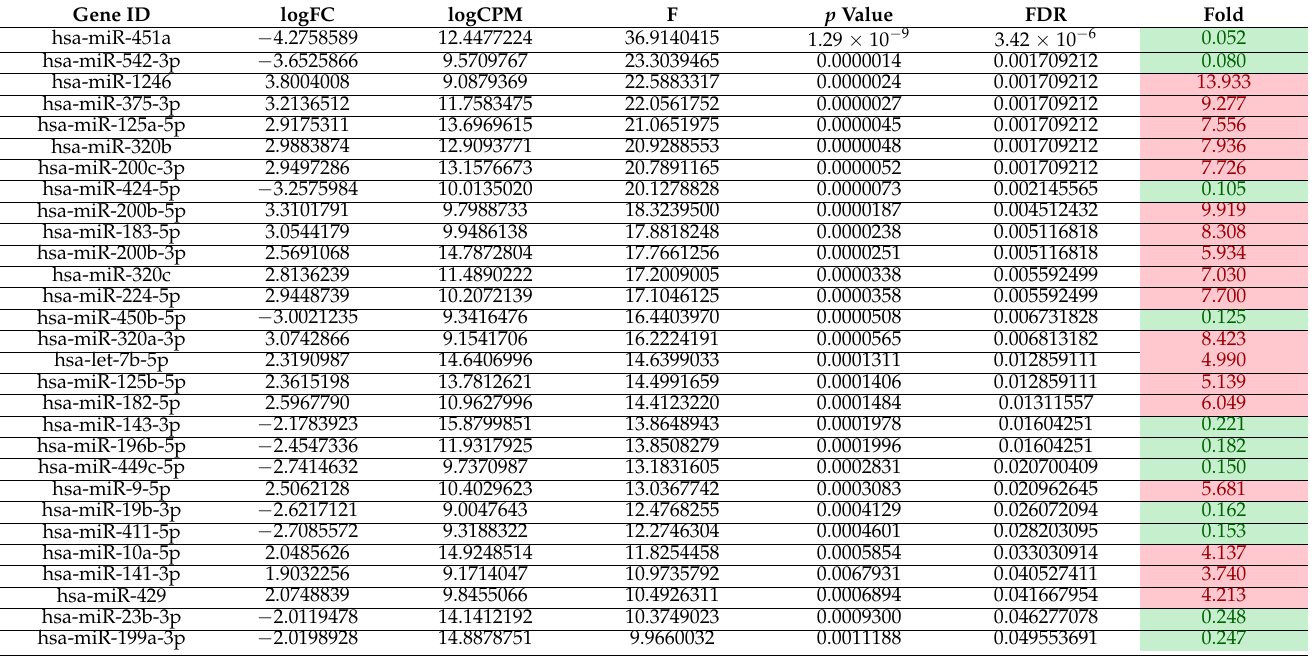
Table 2. Selected miRNAs differently expressed in EVs from the UA of EOC patients and healthy individuals. Criteria for selection: FC > 4, FDR-adjusted p < 0.05, logCPM >